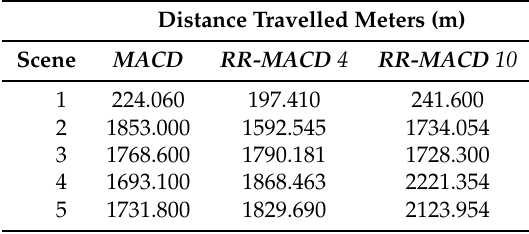
Table 6. Path results in distance metrics.